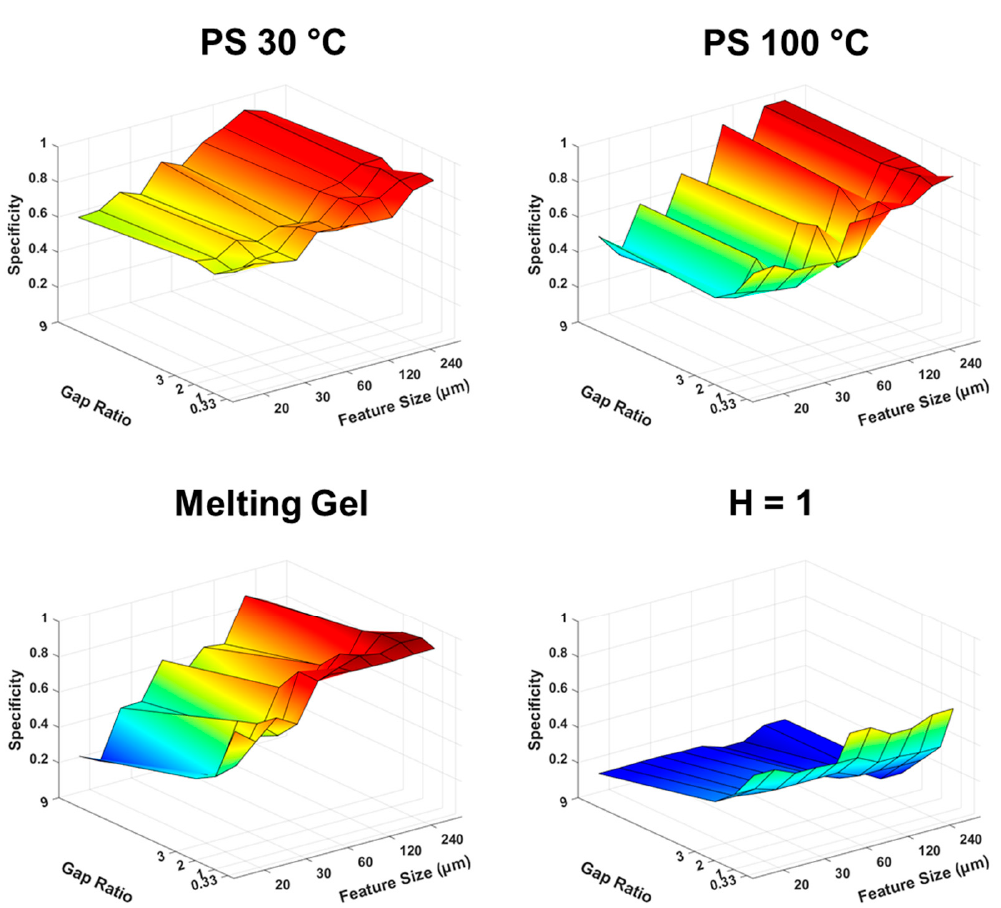
Figure 5. Surface maps of specificity graphed according to the feature size and gap ratio.